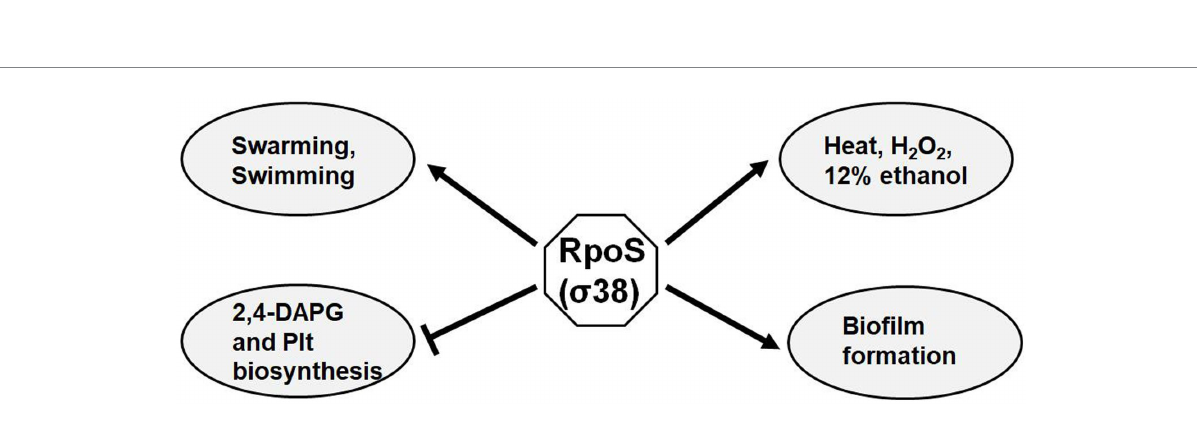
FIGURE 8 Proposed regulatory model of RpoS on biocontrol factors in P. protegens FD6. Arrows, positive regulation; lines with a flattened end, negative